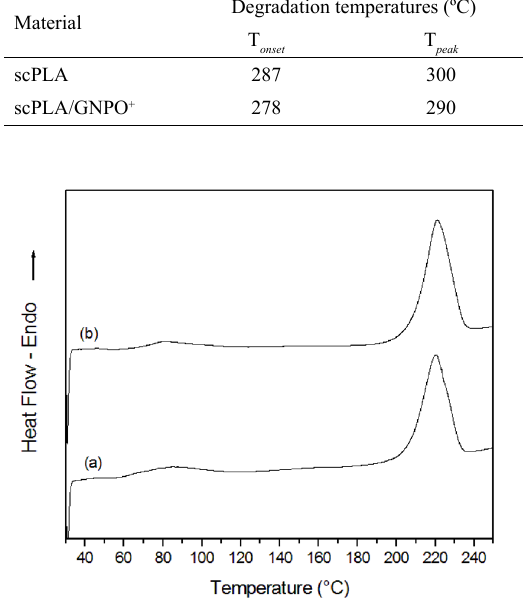
Figure 3. DSC curves of the first heating: (a) scPLA and (b) scPLA/ GNPO+ nanocomposite.